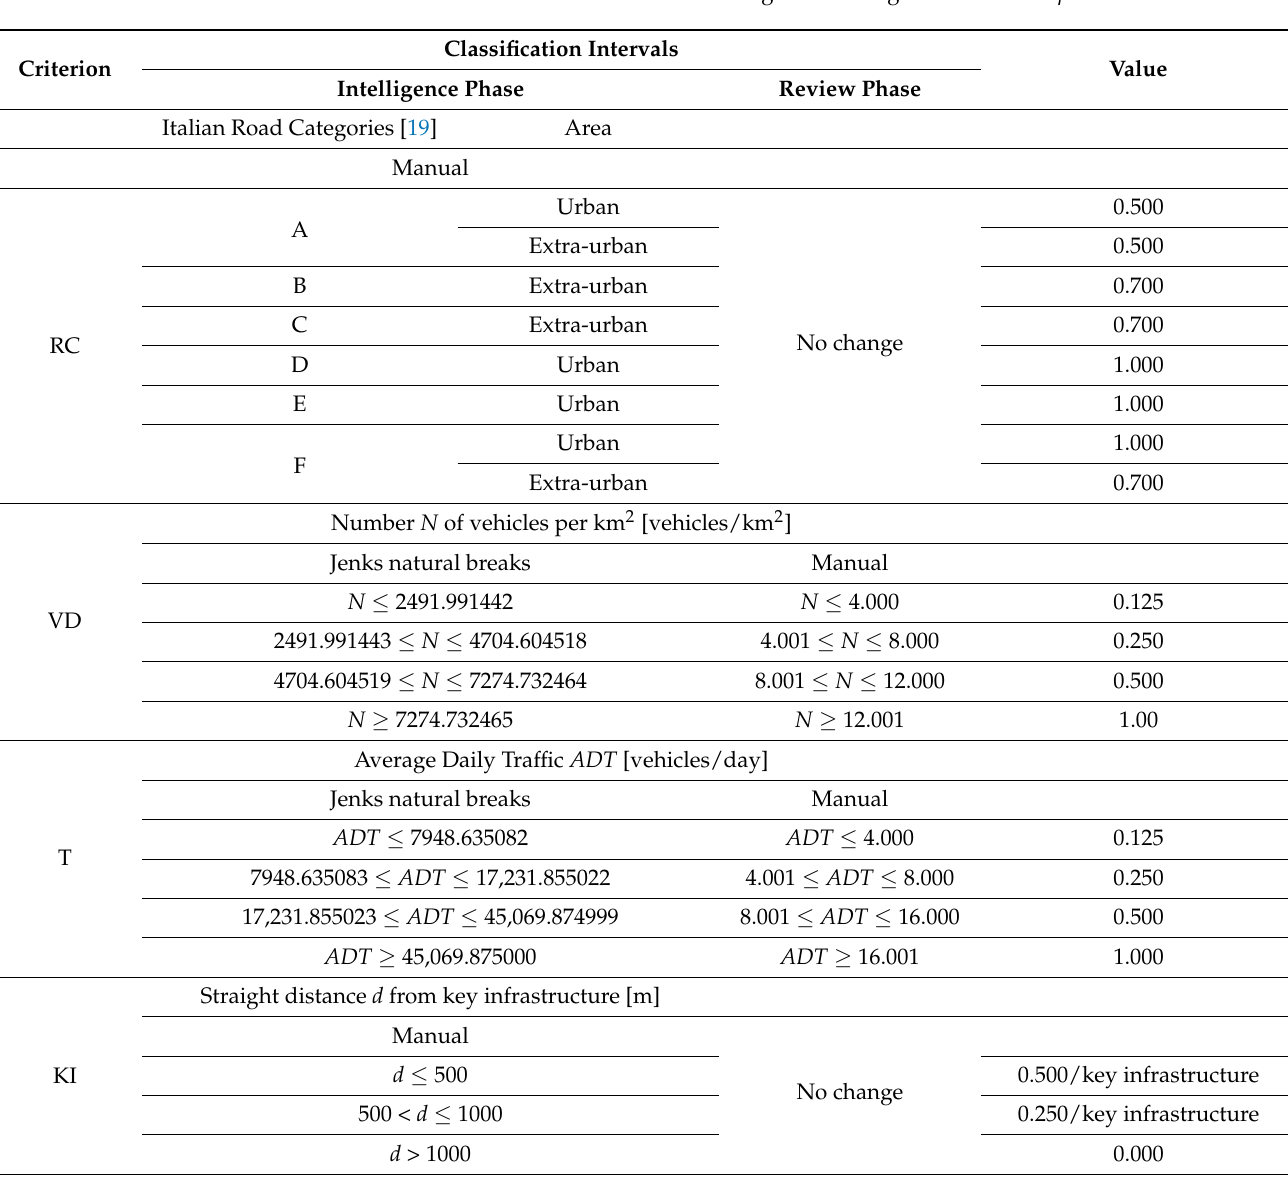
Table 2. Criteria classification intervals during both intelligence and review phase